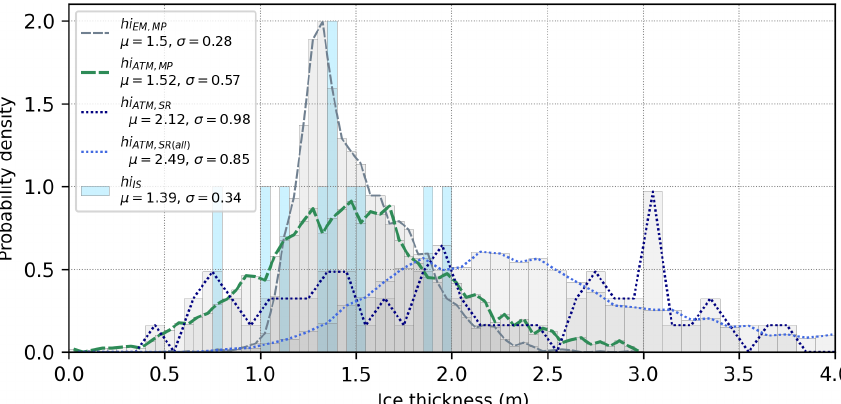
Figure 8. PDFs of sea ice thickness (hi) with given average values ( µ ), standard deviations ( σ ) and number of measurements ( N ) from the 2- D survey field site: hi EM , SP (dashed grey): ice thickness calculated from EM31 total thickness and SP snow depth; hi ATM , SP (dashed green): ice thick calculated from ATM surface elevation and SP snow depth in the 2-D field; hi ATM , SR (dark blue dots): ice thickness calculated from ATM surface elevation and snow radar data using matched OIB ATM and radar observations in the 2-D field; hi ATM , SR ( all ) (blue dots): ice thickness from all ATM surface elevation measurements in a 10km radius around R/V Lance and the mean of all radar snow depth estimates; hi IS (light blue bars): ice thickness measured in situ at drilling sites around the survey